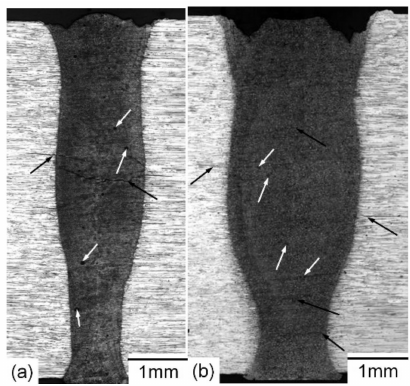
Figure 4. Low-magnification stereoscopic photographs of cross-sections of laser beam-welded joints produced using the low ( a ) and high ( b ) heat inputs. Black arrows indicate micro-cracks, while white arrows indicate